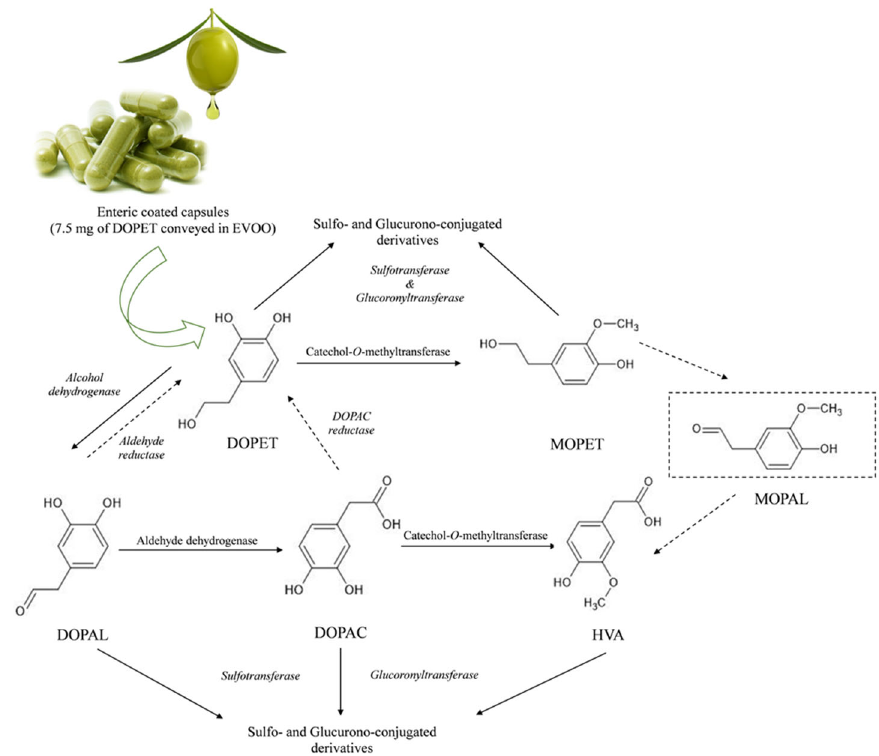
Figure 5. Human metabolic pathways of hydroxytyrosol (3,4-dihydroxy-phenylethanol, DOPET) conveyed in extra virgin olive oil (EVOO) and administered orally as enteric-coated capsules. 4-Hydroxy-3-methoxy-phenylethanol (MOPET); 3-methoxy-4-hydroxyphenylacetaldehyde (MOPAL); homovanillic acid (HVA); 3,4-dihydroxyphenylacetic acid (DOPAC); 3,4-Dihydroxyphenylacetaldehyde